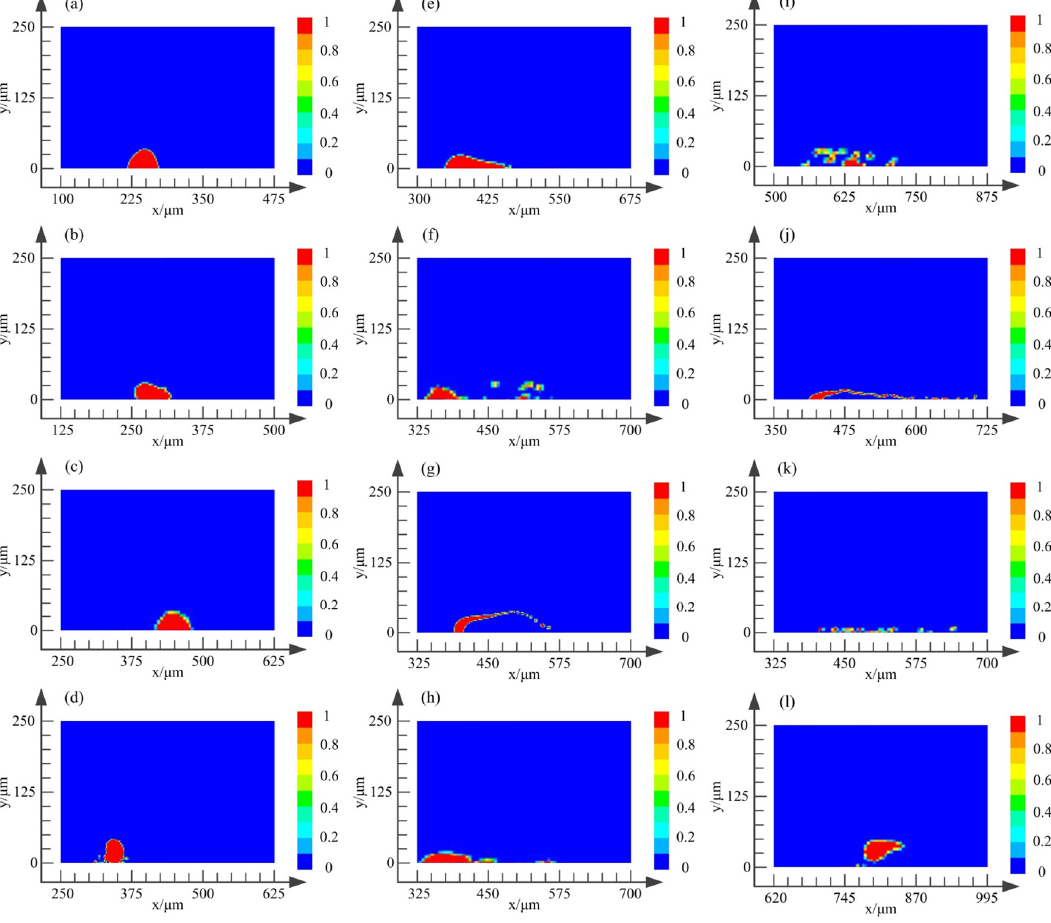
Figure 13. Volume fraction profiles of the bubble bursting on the wall at different flow velocities: (a)